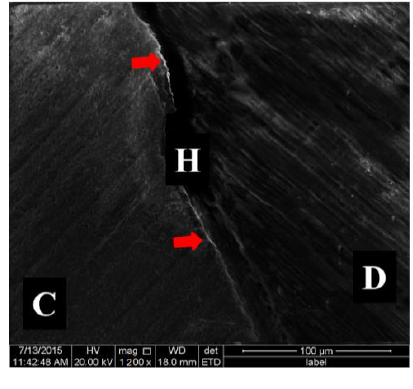
Figure 5: Representative backscattered SEM images of the resin–dentine interfaces of group (V) 10% NaOCL surface conditioning. (C composite, H hybrid layer, D dentine, red arrow refer to